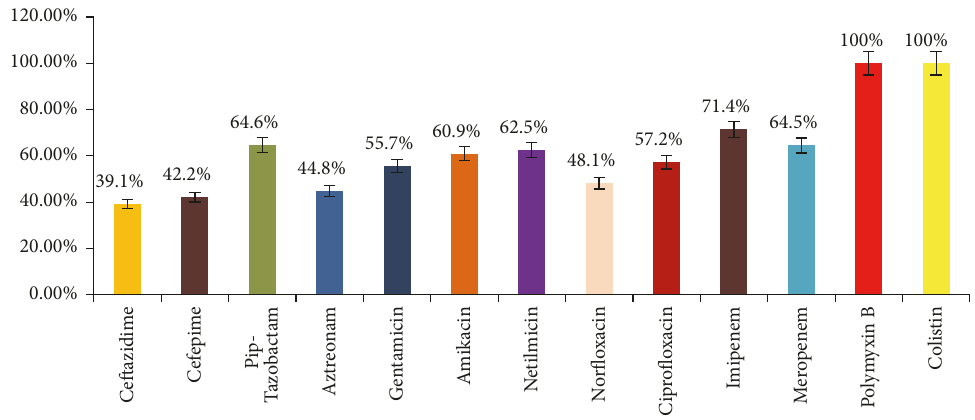
Figure 3: Antimicrobial susceptibility profile of P. aeruginosa (N=192).